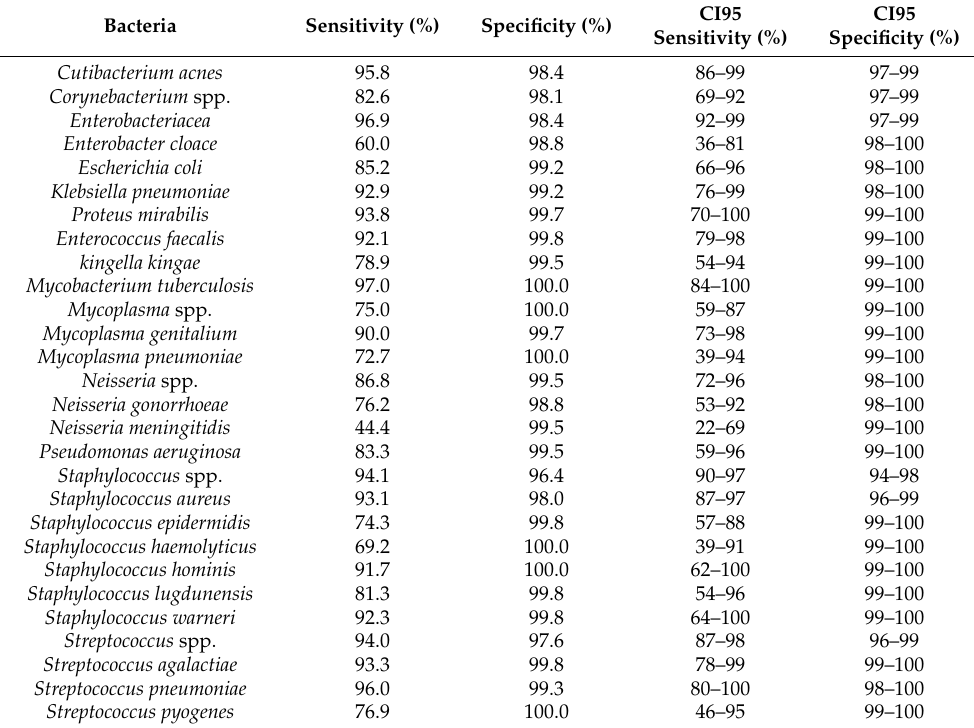
Table 2. Sensitivity and specificity for each bacterium detected on the DendrisCHIP ® OA determined as described in Materials and